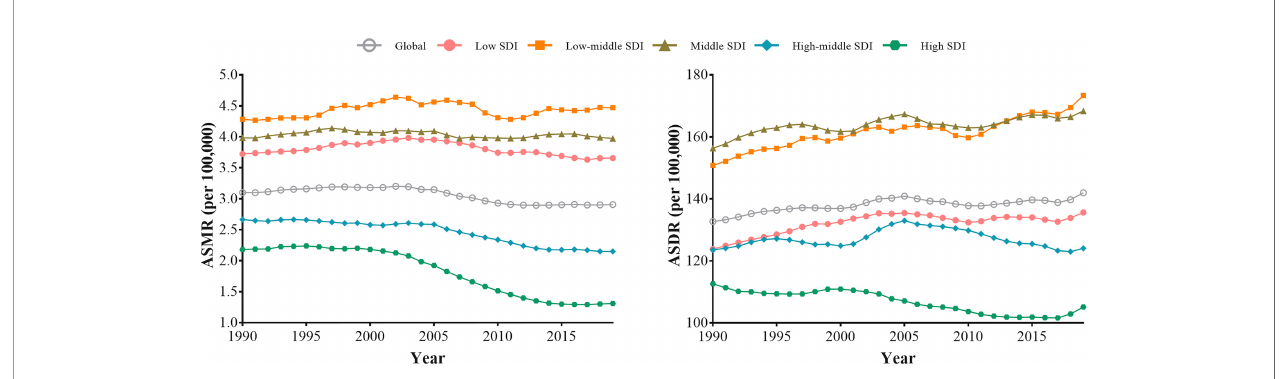
FIGURE 2 | The trends in the ASMR and ASDR for type 2 diabetes attributable to tobacco globally and among fi ve SDI regions from 1990 to